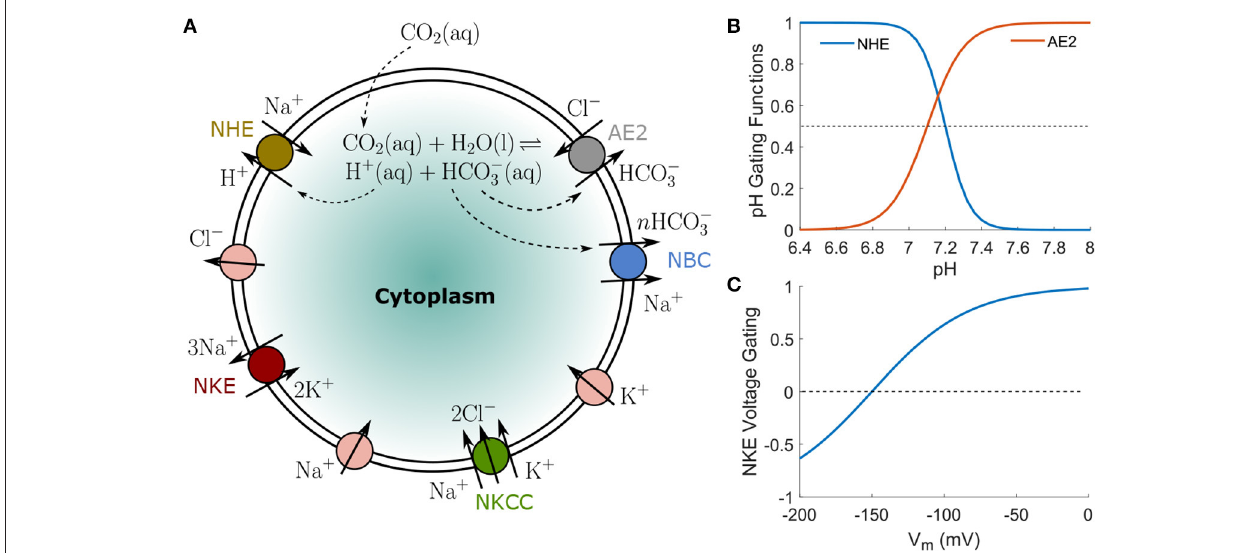
FIGURE 1 | (A) A schematic representation of ion pumps, transporters and passive channels included in the model to compute cell ion homeostasis. The ion fluxes can depend on intracellular and extracellular ion concentrations, transmembrane potential, the tension in the cell cortex, and expression/activation levels of each channel (see Methods). The overall cell ionic composition depends on ion channel/transporter/pump expression and activation. (B) pH-gating profiles of NHE and AE2 transporters, taken from data in Casey et al. (2010). (C) Voltage-gating profile for NKE, taken from data in Gadsby et al.